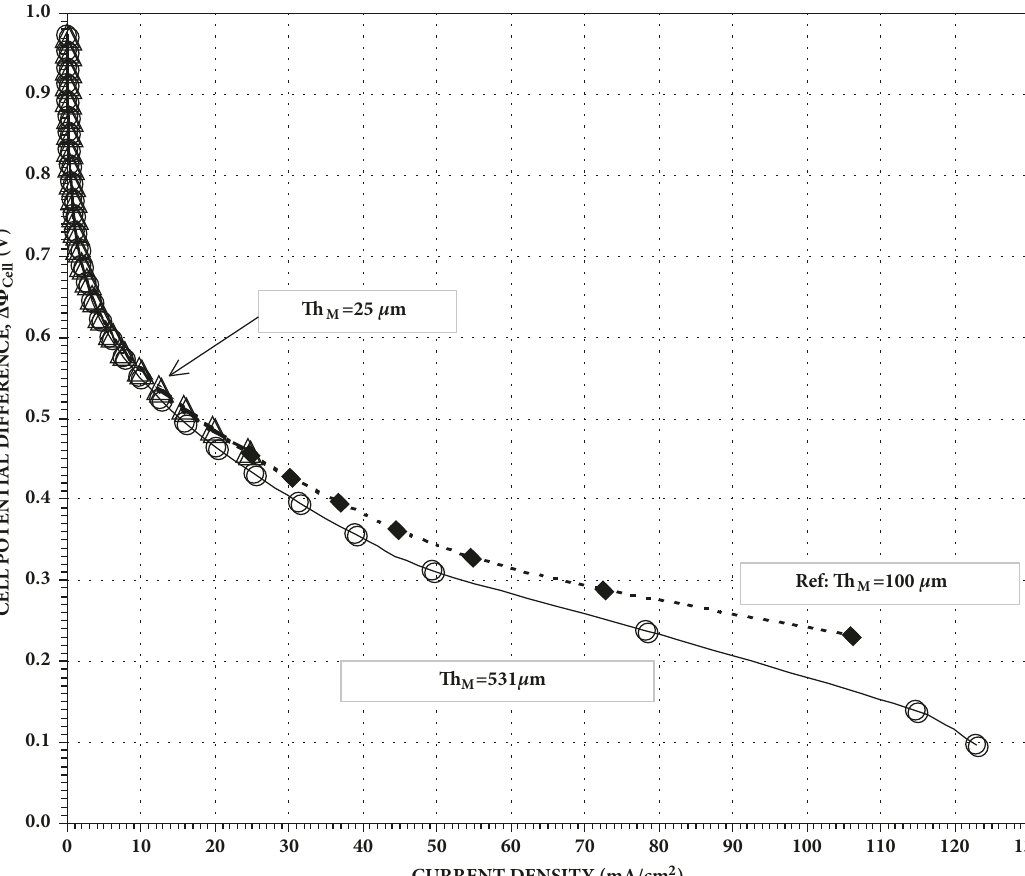
Figure 6: The effect of the electrolyte (membrane) layer thickness, Th ( 𝜇 m), on the polarization curve for a direct propane fuel cell (DPFC) M model at 150 ∘ C and 1 atm. The values of Th ( 𝜇 m) for the above three cases were represented by the following symbols: (i) open triangles: 25 M 𝜇 m, (ii) solid diamonds: 100 𝜇 m (reference case), and (iii) open circles: 531 𝜇 m. All the other parameters were the same as the reference case mentioned in Table